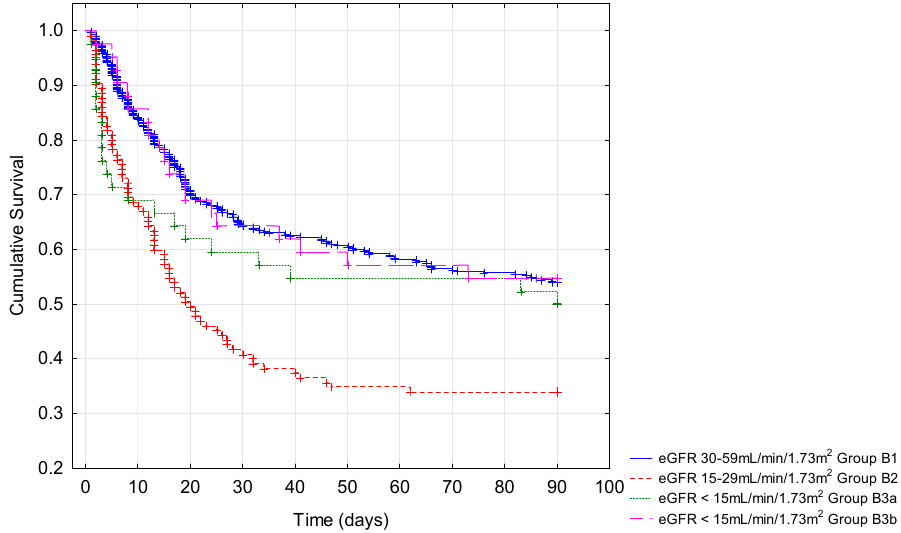
Figure 1. Kaplan–Meier cumulative survival analysis among patients with eGFR < 60 mL/min/1.73 m 2 divided into four subgroups based on eGFR level at admission to hospital. Group B1: eGFR < 30–59 mL/min/1.73 m 2 ; group B2: eGFR 15–29 mL/min/1.73 m 2 ; group B3a: <15 mL/min/1.73 m 2 without renal replacement therapy; group B3b < 15 mL/min/1.73 m 2 on